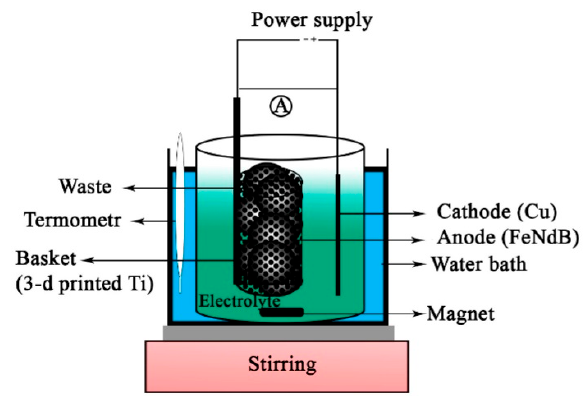
Figure 11. Schematic picture of electro-leaching in a Ti basket [60]; published by Elsevier, 2020. Metals 2020 , 10 , x FOR PEER REVIEW